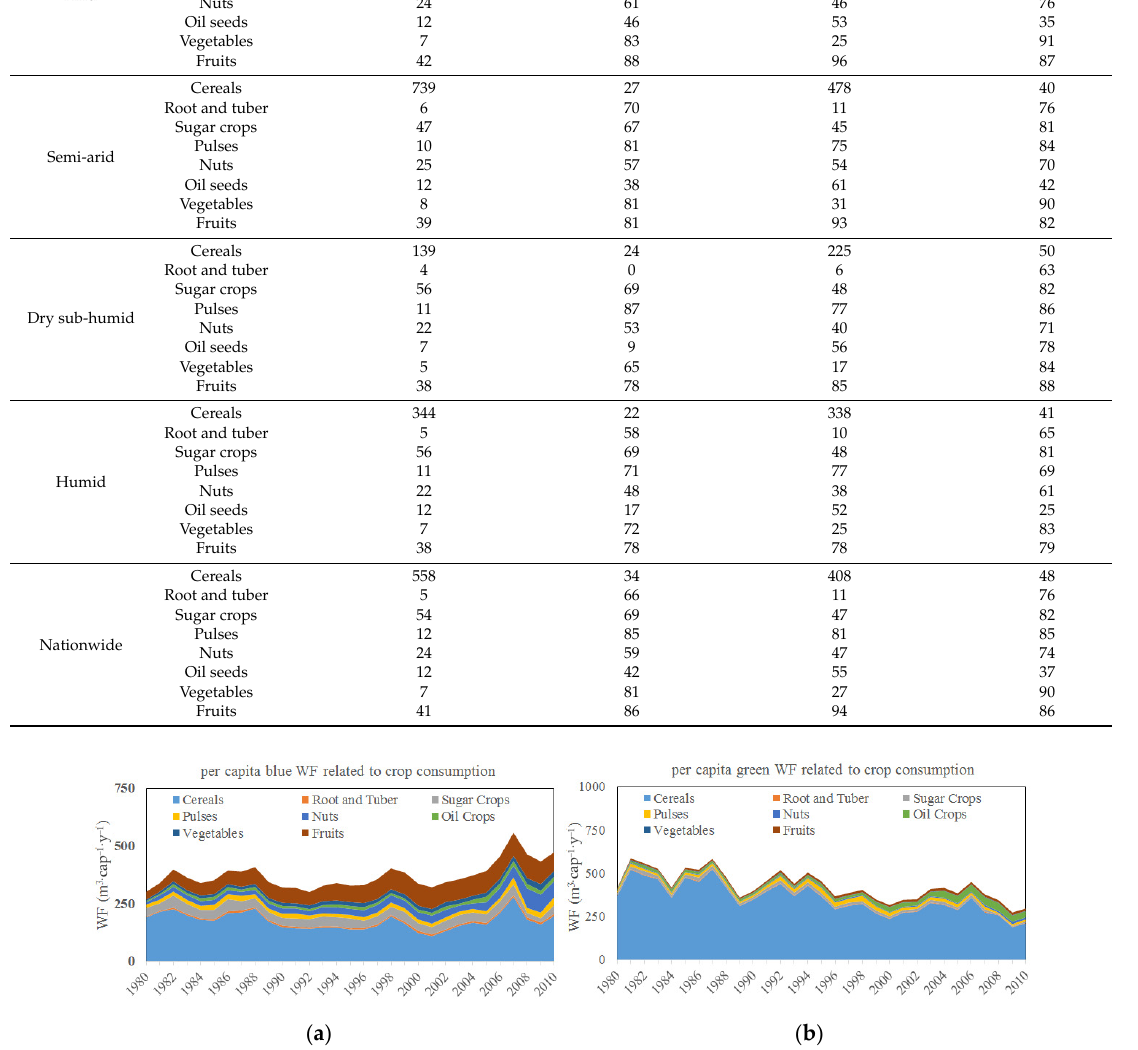
Figure 6. Blue WF ( a ) and green WF ( b ) of Iranian crop consumption per capita, over the period 1980–2010.